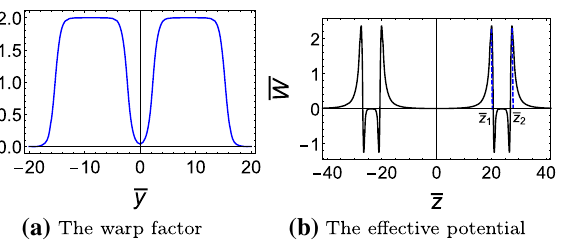
Fig. 19 The warp factor and the effective potential W ( ¯ z ) for case 3.